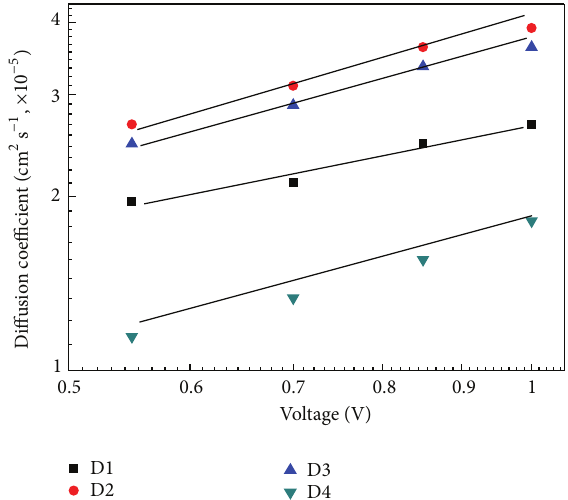
Figure 6: Diffusion coefficient of chitosan sol-based DSSCs.